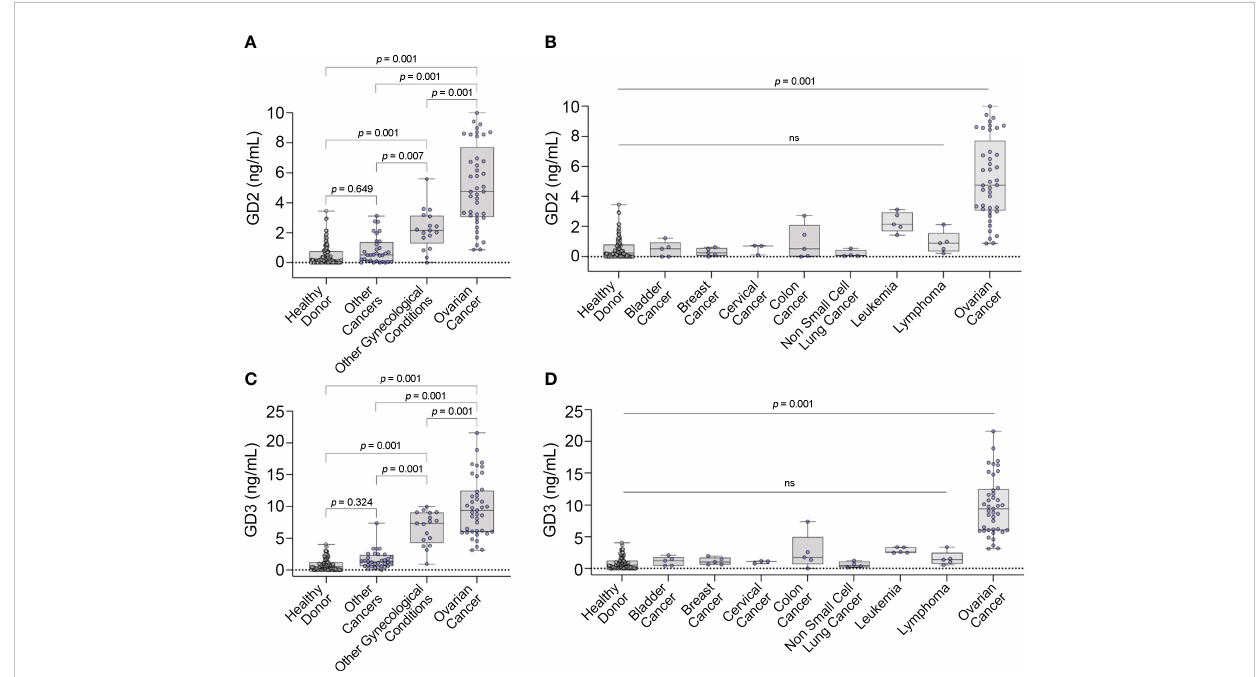
FIGURE 3 GD2 and GD3 expression in serum. Box plots displaying concentrations of (A) GD2 and (C) GD3 versus different controls. Box plots displaying concentrations of (B) GD2 and (D) GD3 with other cancers by cancer type. Box plots show median, upper and lower quartiles, and max/min values. Dots represent individual values. ns, not signi fi